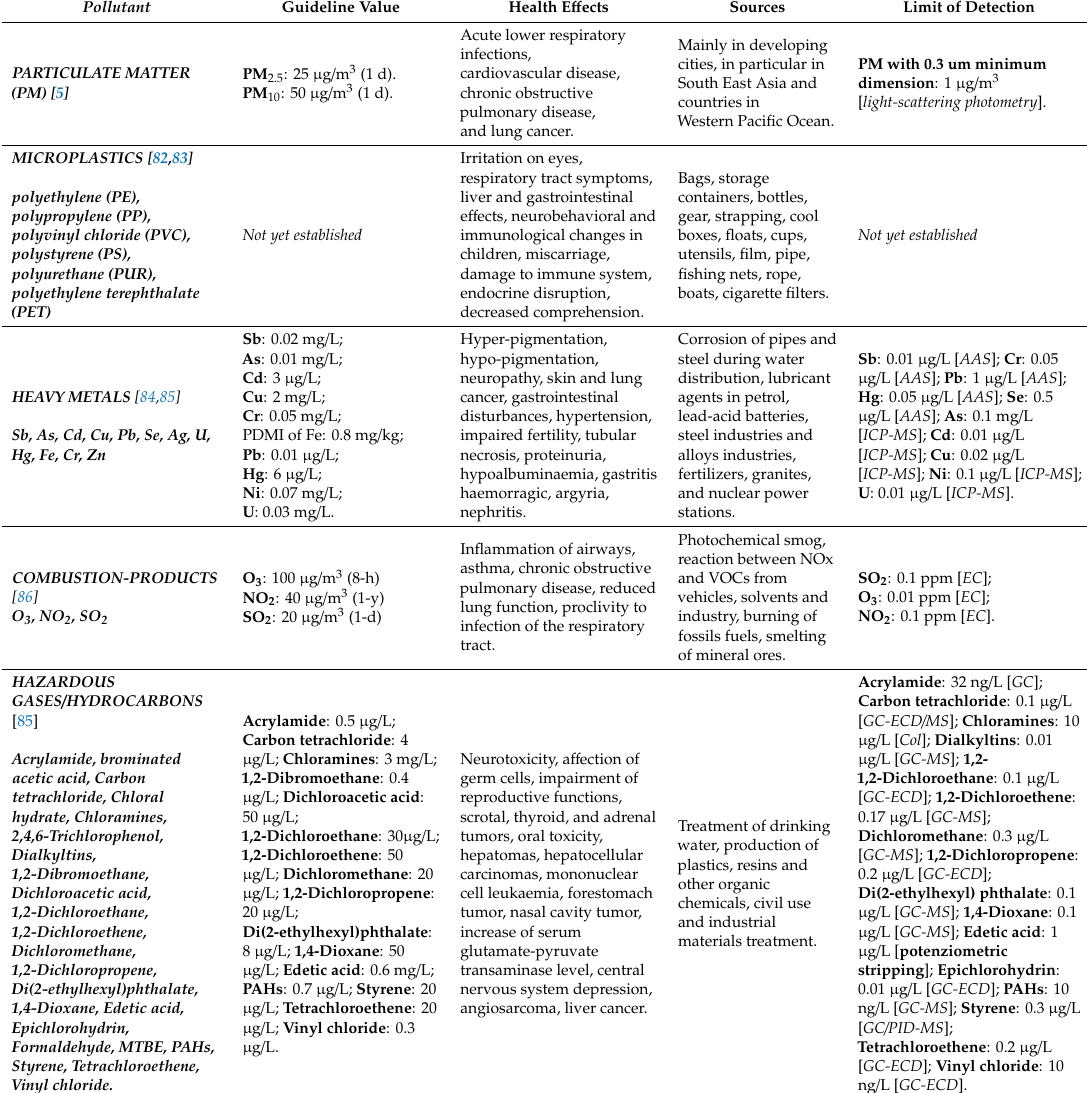
Table 1. Summary of contaminants characteristics, e ff ects, and available sensing technologies for their monitoring. Pollutant Guideline Value Health E ff ects Sources Limit of Detection PARTICULATE MATTER (PM) [5]